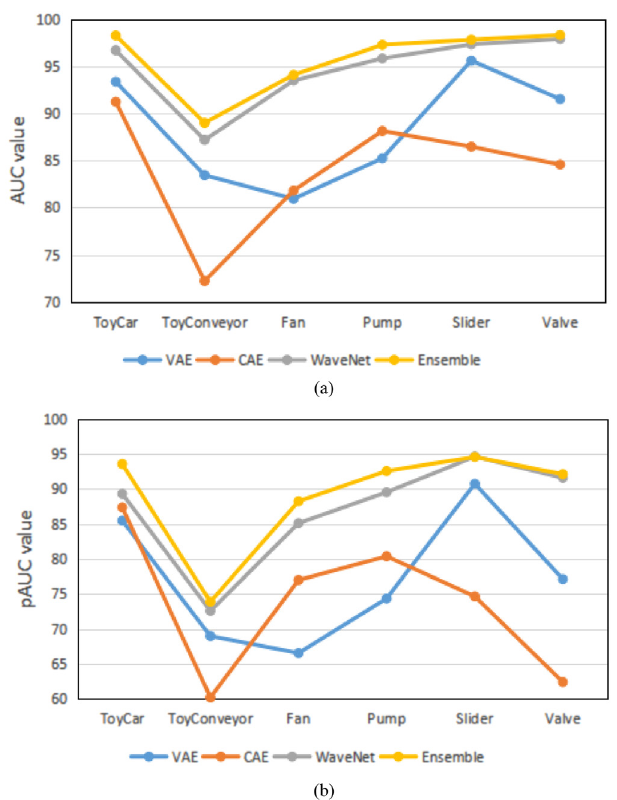
Fig. 9. Comparison line chart of each model: (a) line chart of AUC value; (b) line chart of pAUC